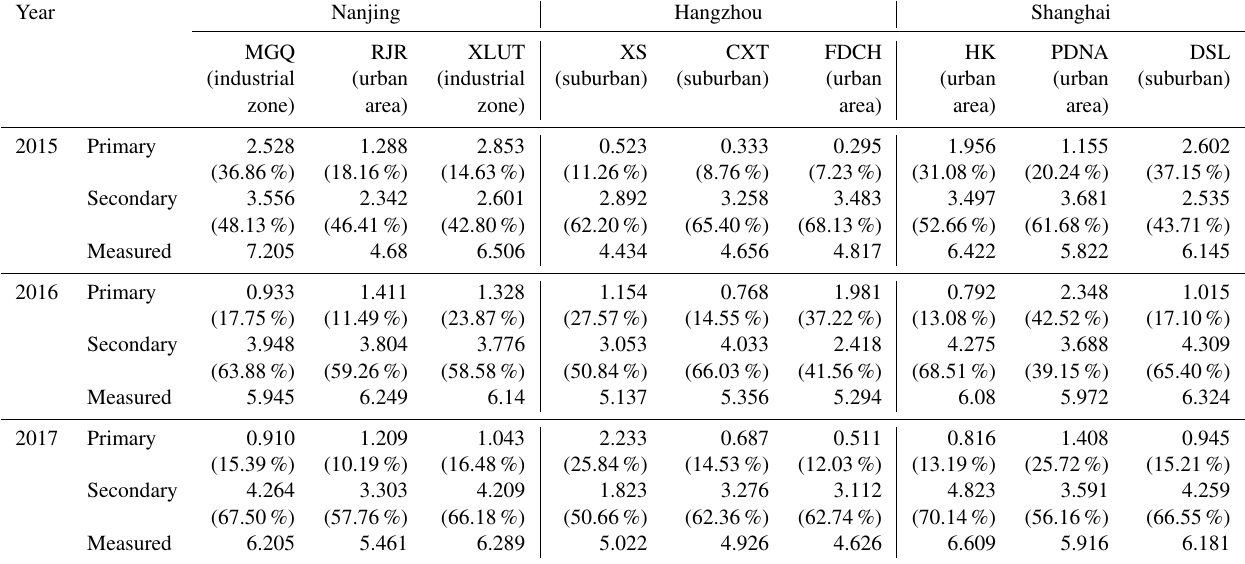
Table 1. Annual average of the measured HCHO concentrations (ppbv) and absolute and relative contributions from different sources in Nanjing, Hangzhou, and Shanghai. The values in parentheses represent the contributions from different sources; lines 1–2 in each year refer to primary HCHO, lines 3–4 refer to secondary HCHO, and line 5 refers to measured HCHO.